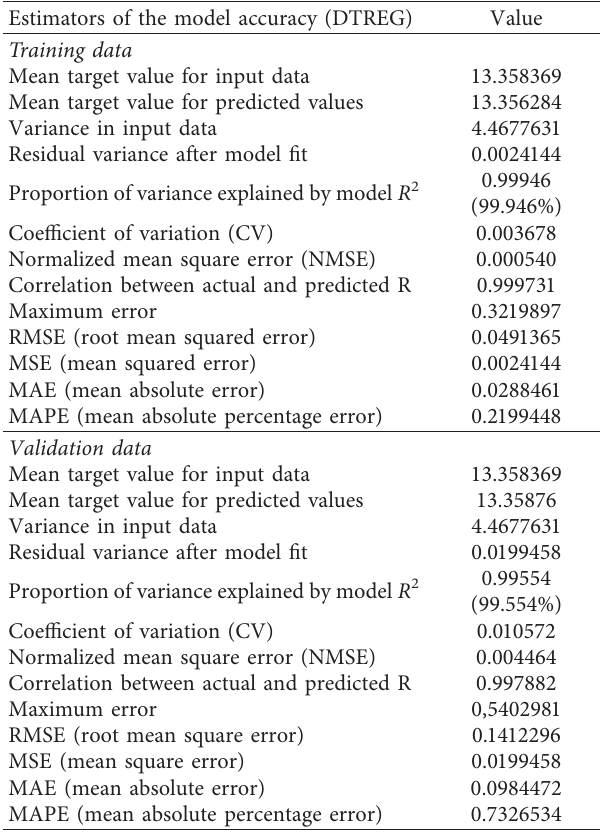
Table 1: Results for the training and validation data (DTREG